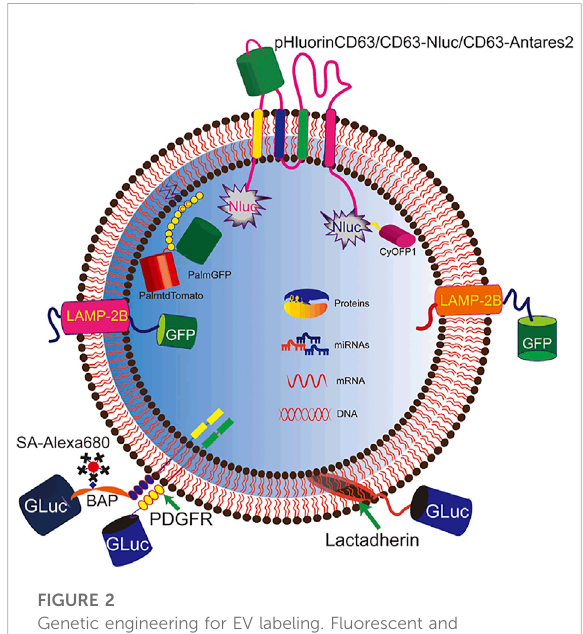
FIGURE 2 Genetic engineering for EV labeling. Fluorescent and luminescent proteins are tagged to EVs for labeling. Signal molecules (pHluorin, NLuc, Antares2, GFP, and GLuc) are introduced to EVs by tagging to membrane proteins (CD63, Lamp2B, and PDGFR), membrane-binding protein (lactadherin), and lipid tail